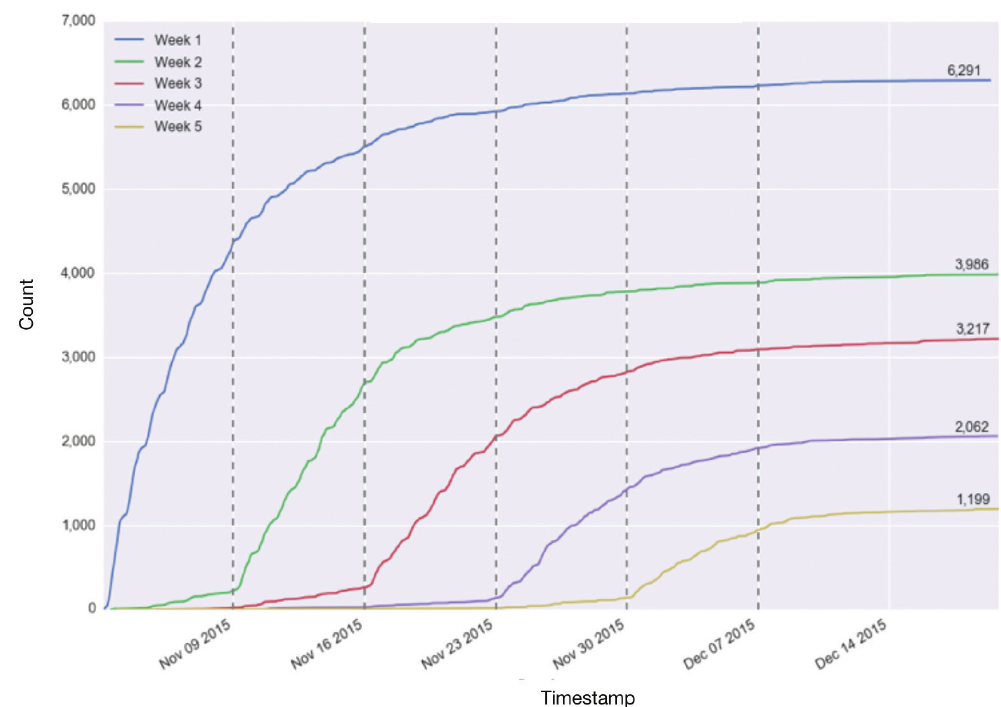
Figure 3: Volume and pattern of comments in BLE 1 run 1 by week